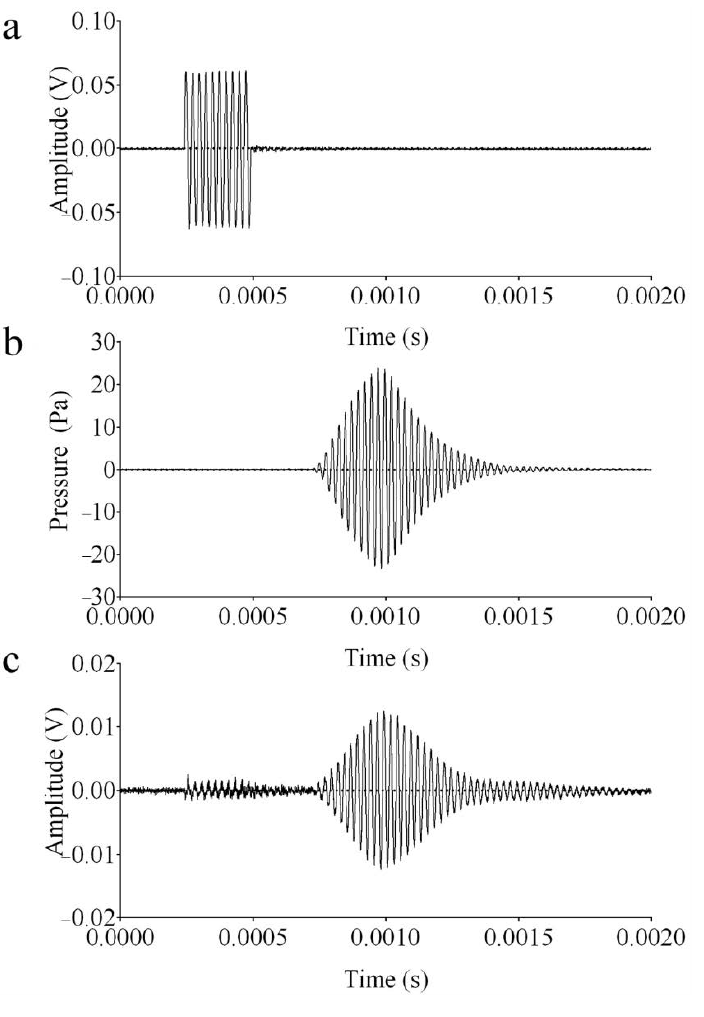
Figure 10. Pulse-echo signal acquisition where ( a ) is the excitation burst of the transducer, ( b ) highlights the pressure received by the spiral shaped-sensor, and ( c ) is the signal received at the output of VCII.